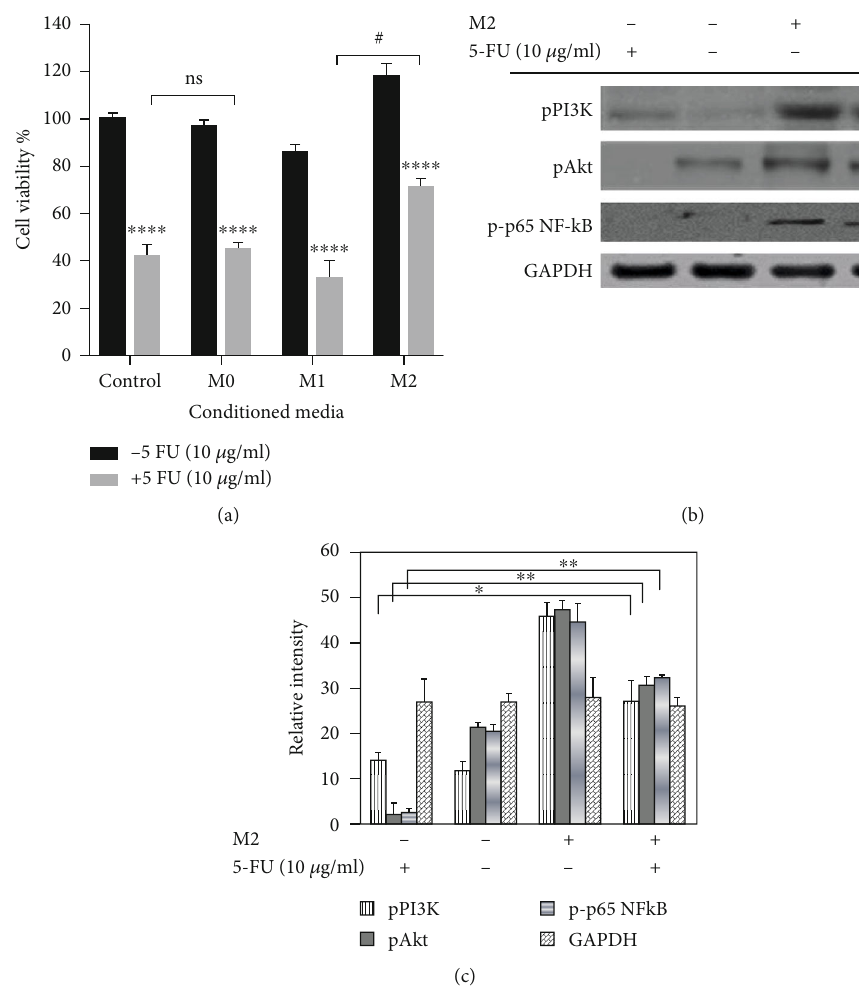
Figure 3: (a) Cell viability of AGS cells treated with 5FU with conditioned media from polarized macrophages. AGS cells were plated in 96- well plates and incubated for 24 h at 37 ° C. After 24h of incubation, the media were replaced with a mixture of fresh media and conditioned media (CM) from macrophages to a fi nal ratio of 60 :40, respectively (control=no CM, M0 =CM from PMA-di ff erentiated THP-1 cells, M1 =CM from THP-1 cells activated with LPS, and M2 =CM of THP-1 cells activated with IL-4). 5FU was simultaneously added to the cell to a fi nal concentration of 10 μ g/ml and the plates were incubated for 24h. After treatment, the media in the plate was removed and replaced with fresh media, and then 10 μ l of WST-1 solution was added in each well, and the plate was incubated for further 4 h at 37 ° C. Absorbance was obtained using the ELISA microplate reader at 490nm wavelength. (b) Proliferation of AGS cells cocultured with M2 macrophages. AGS cells were plated in 6-well plates and incubated for 24 h at 37 ° C. After 24h of incubation, AGS cells were treated with 10 μ g/ml of 5FU, and then polarized THP-1-M2 macrophages cultured in 6-well plate inserts of 0.4 μ m pore size were added to the AGS wells and incubated for additional 24h. After treatment, proteins were extracted from AGS cells and separated by Western blot. (c) Quanti fi cation of western blot bands. Statistically signi fi cant di ff erence was set at # P < 0 : 05 , ∗ P < 0 : 05 , ∗∗ P < 0 : 01